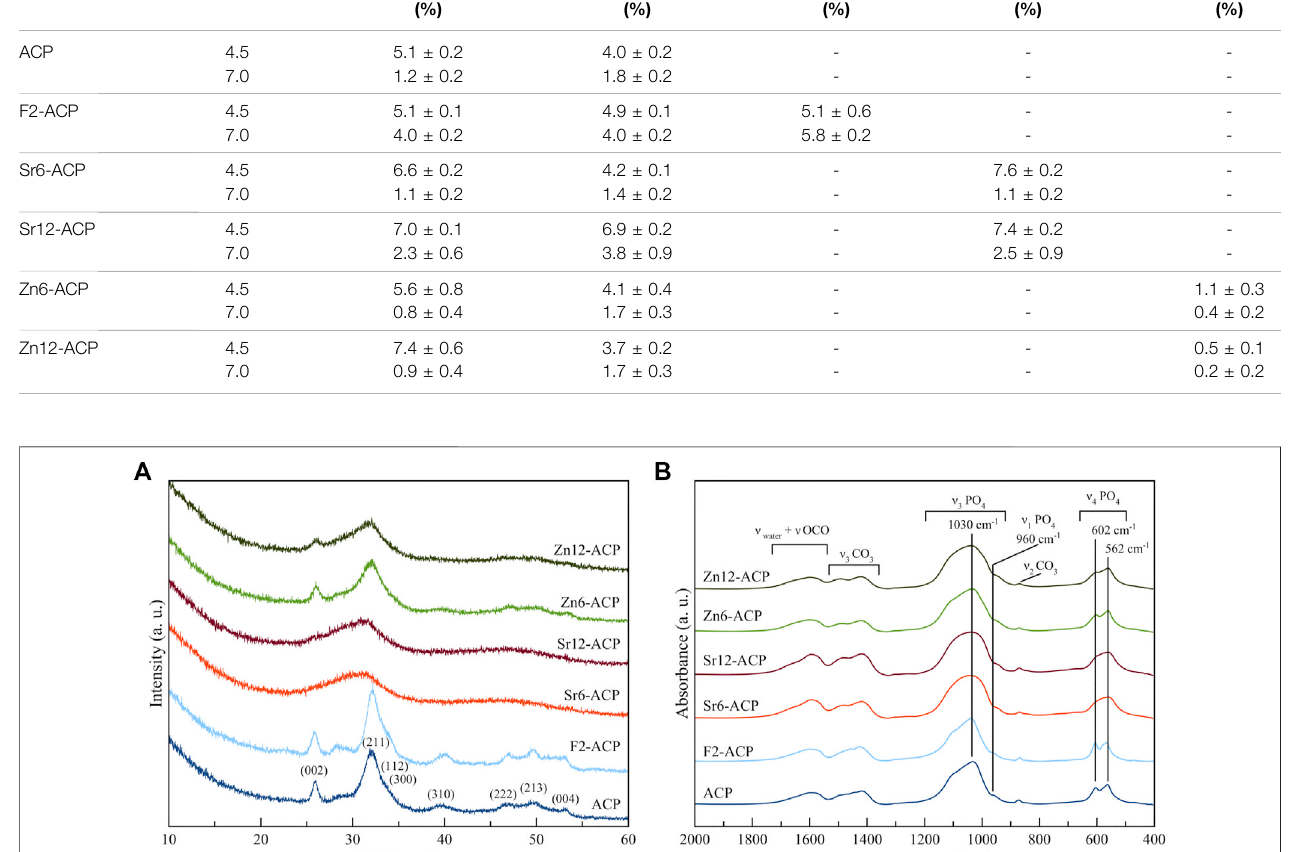
TABLE 2 | Amounts of ions released by ACP samples under neutral and acidic pH conditions, as assessed by ICP-OES and ISEF. The acidic conditions reproduce the challenge of a metabolically active, cariogenic bio fi lm. Sample Slurry pH